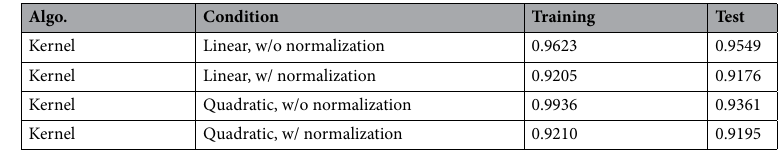
Table 4. Results of 5-fold CV with 5 different random seeds of the kernel method for the cancer dataset (0 or 1). We set (cid:31) = 10 − 1 . For φ( · ) , we use linear and quadratic functions with and without normalization.